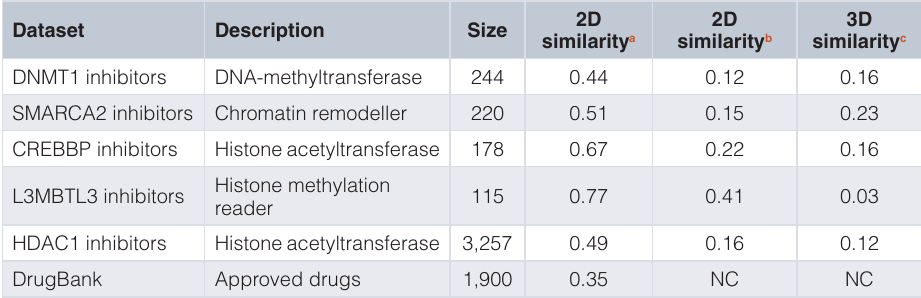
Table 1. Compound data sets used in the study.